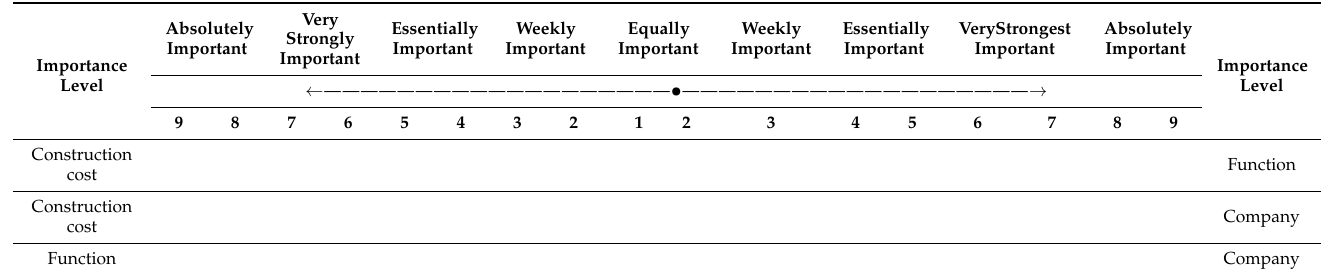
Table 3. Pairwise independence questionnaire.